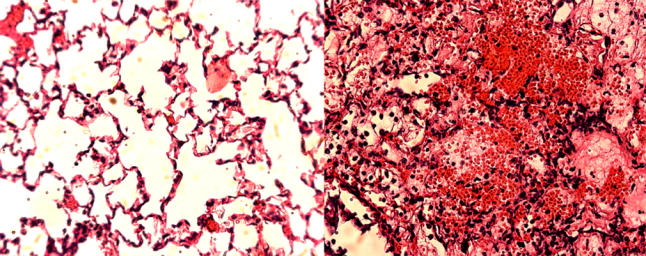
Lung tissue under ambient oxygen levels (left) and under 100% oxygen (right), which exacerbates acute inflammatory lung injury